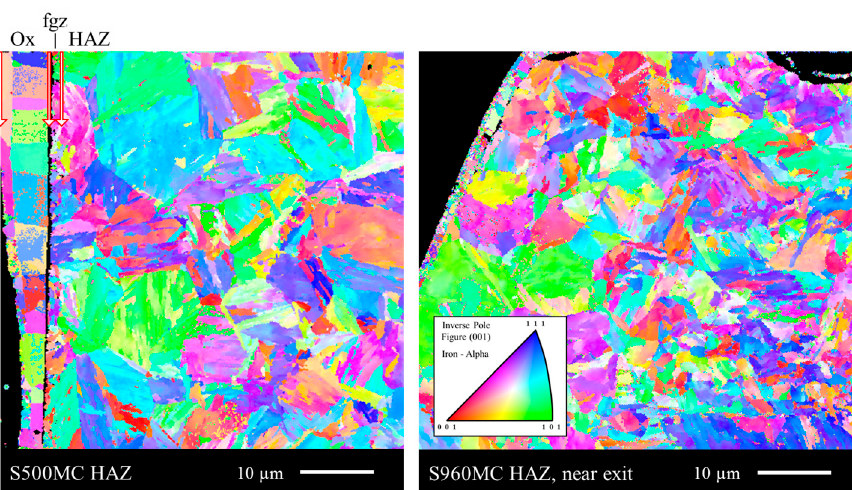
Figure 14. Hole edges of S500MC and S960MC measured with electron backscatter diffraction (EBSD).